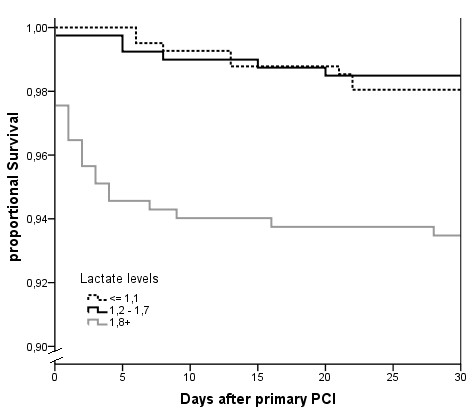
Kaplan-Meier curve displaying 30-day proportional survival after primary PCI. PCI, percutaneous coronary intervention.